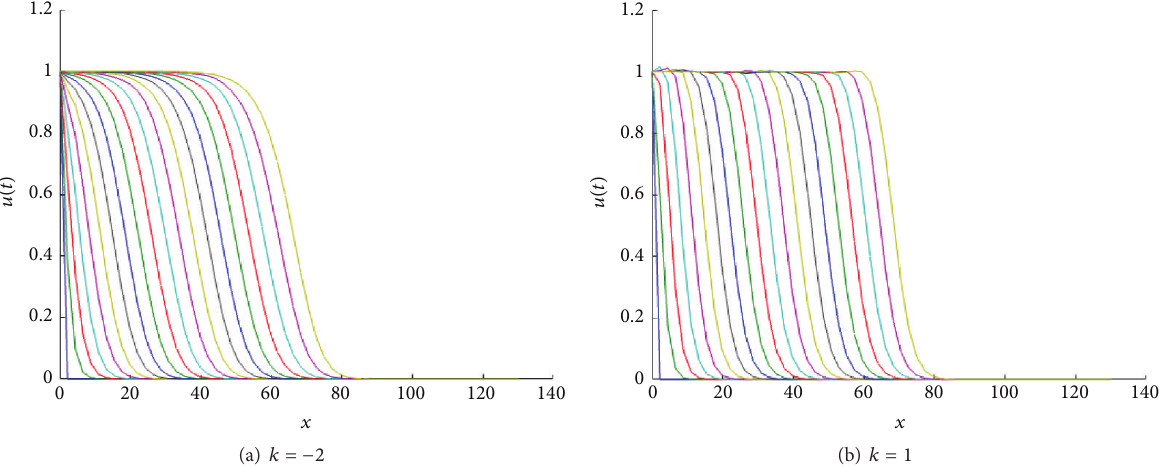
Figure 13: Front traveling waves solutions of (39) for ℎ 󸀠 (𝑢) = 𝛼 + 𝛾𝑢 at equal time intervals 𝑡 = 1,2,3, .. . with 𝑔(𝑢) = 𝑢(1 − 𝑢) and 𝐷(𝑢) = 𝑢(1.0 + 𝛽𝑢) for 𝛽 = 1 . The values for 𝑘 are indicated in each figure.